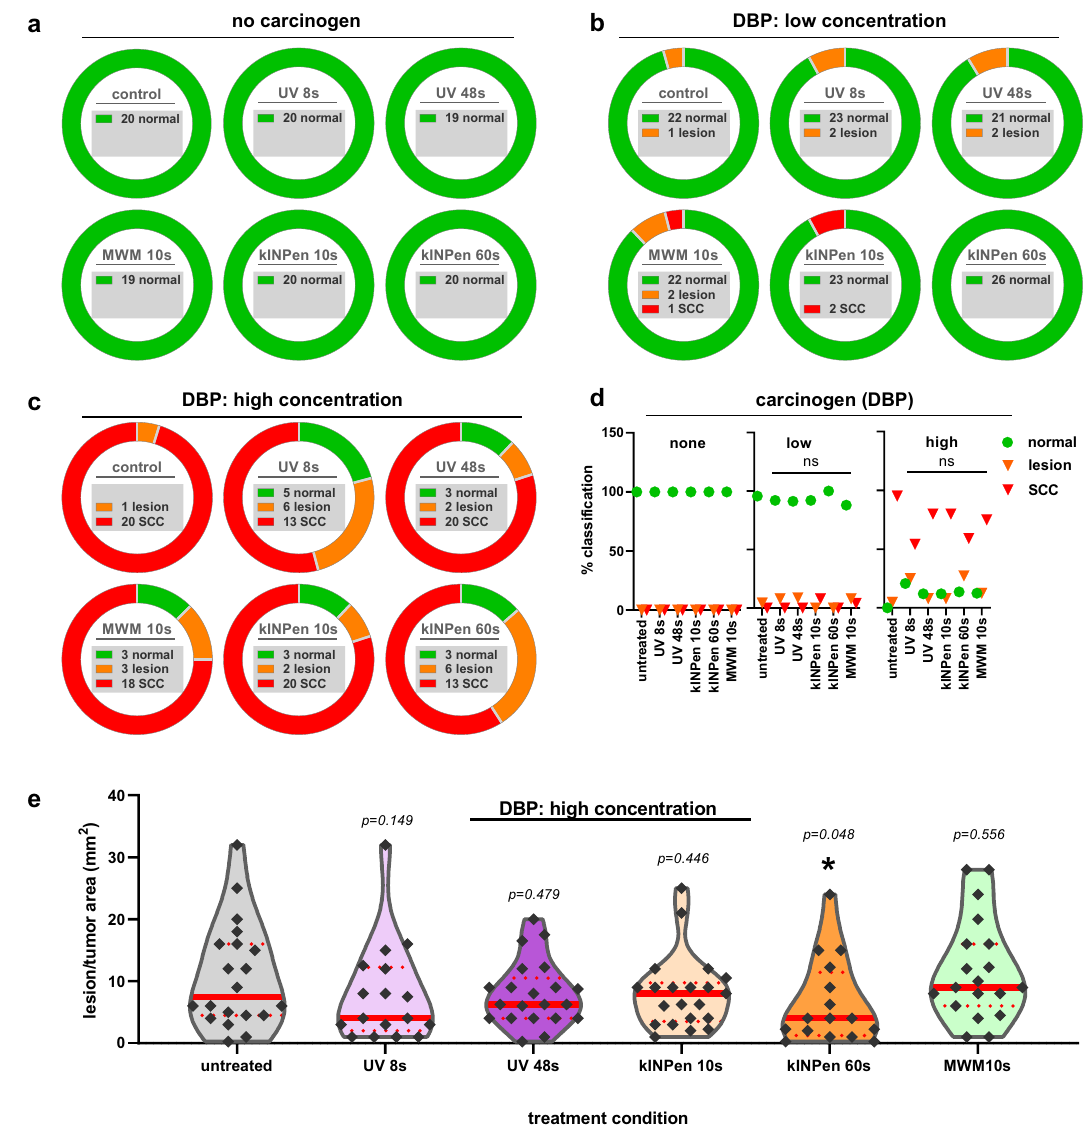
Figure 5. Frequencies and size of lesions and squamous cell carcinoma (SCCs). ( a ) the number of lesion-free and animals across all groups without administration of the co-carcinogen dibenzo(a)pyrene (DBP) indicating an absence of lesions with either of the treatments; ( b ) the number of lesion-free and animals across all groups with low dose (8 nmol) administration of the co-carcinogen DBP indicating the occurrence of 1–2 lesions or SSCs with either of the treatments; ( c ) the number of lesion-free and animals across all groups with high dose (24 nmol) administration of the co-carcinogen DBP indicating the occurrence of less than 20% of lesions or SSC-free animals with either of the treatments; ( d ) summary of results shown as percent histological result per DBP administration and treatment subgroup; ( e ) violin plots with single data showing the median (full red line) and 25% percentile (dotted red line) suggesting a lesion and SCC-reducing effect of 60 s of kINPen plasma treatment. Statistical analysis was performed using Fisher exact tests ( d ) and Kruskal–Wallis one-way analysis of variances ( e ) with p < 0.05 considered to be statistically significant (*); n =